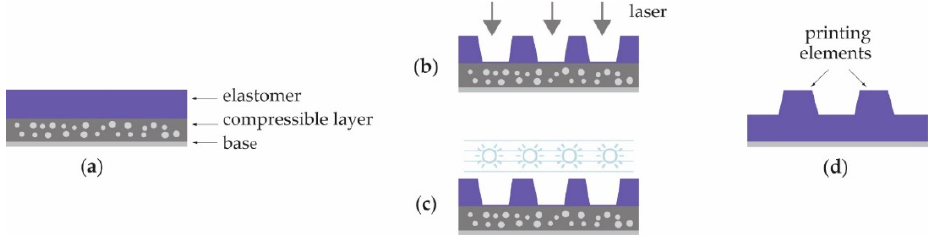
Figure 2. Production phases of the ethylene propylene diene monomer (EPDM) printing plate: ( a ) Section of the printing plate, ( b ) laser engraving, ( c ) washing of the plate, ( d ) finished plate.